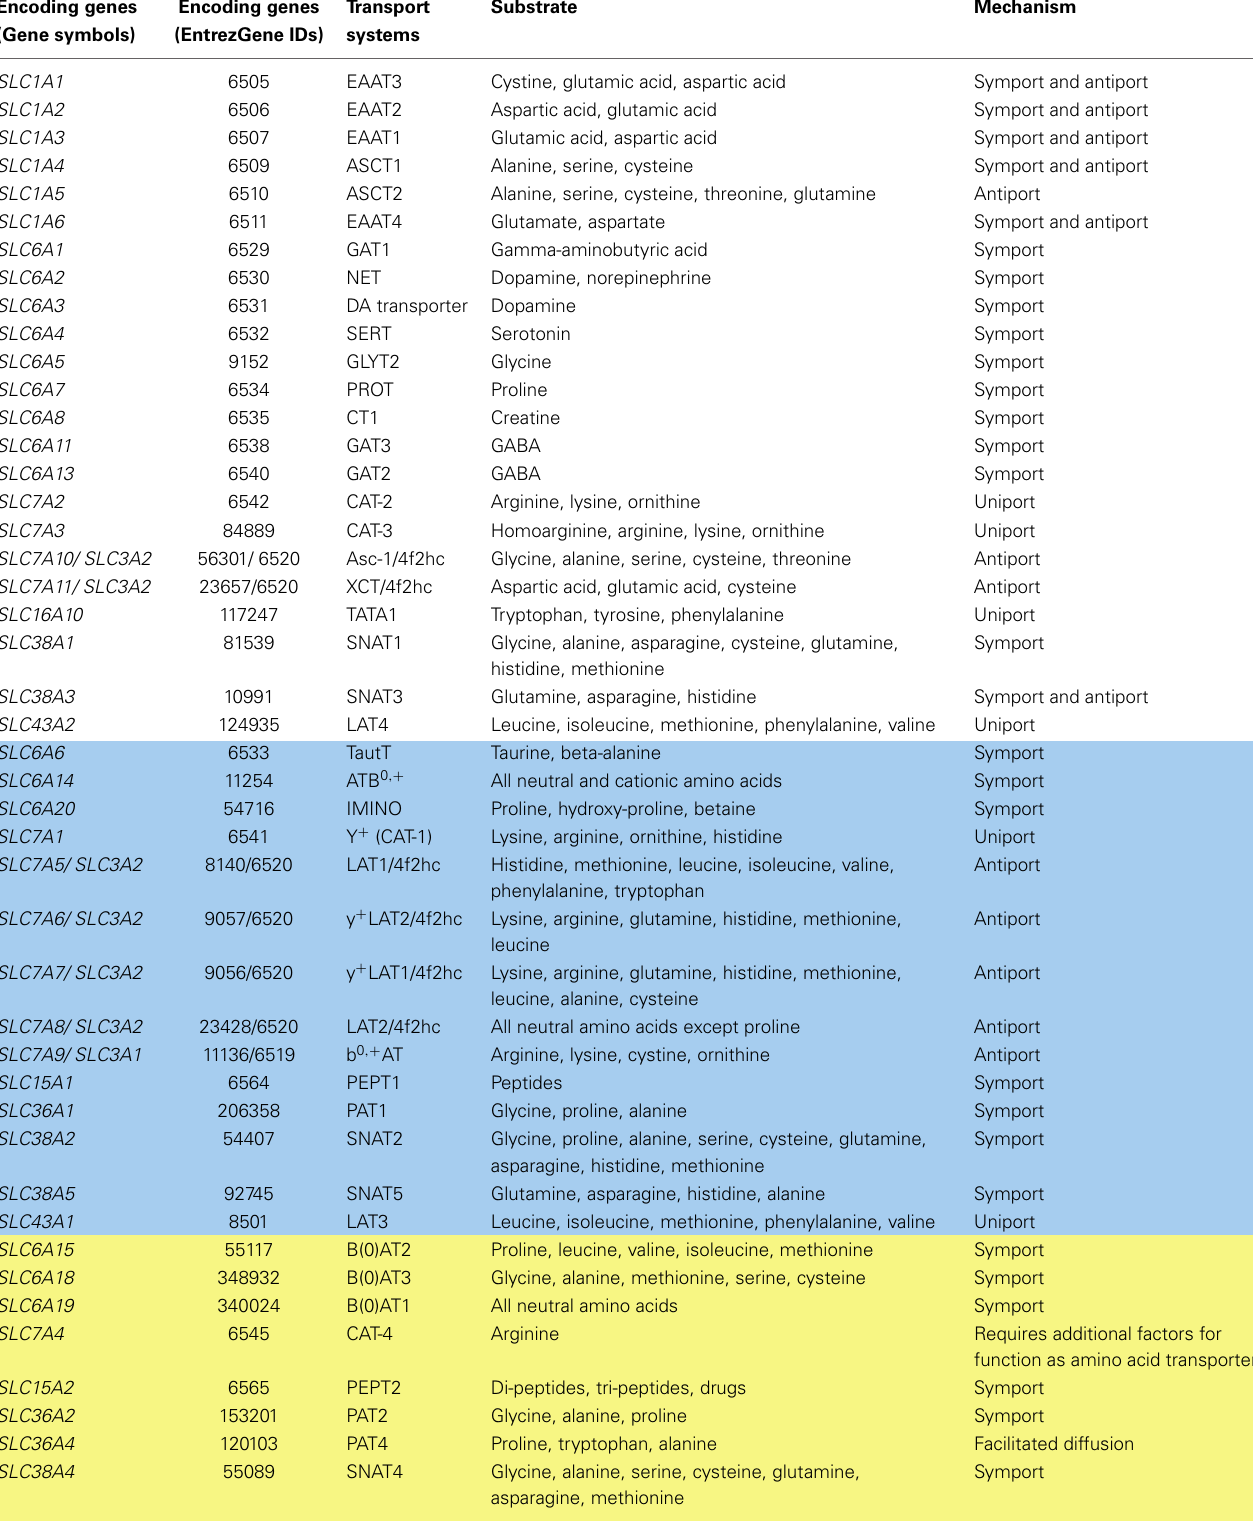
Table 2 | Amino acid transport systems. Encoding genes Encoding